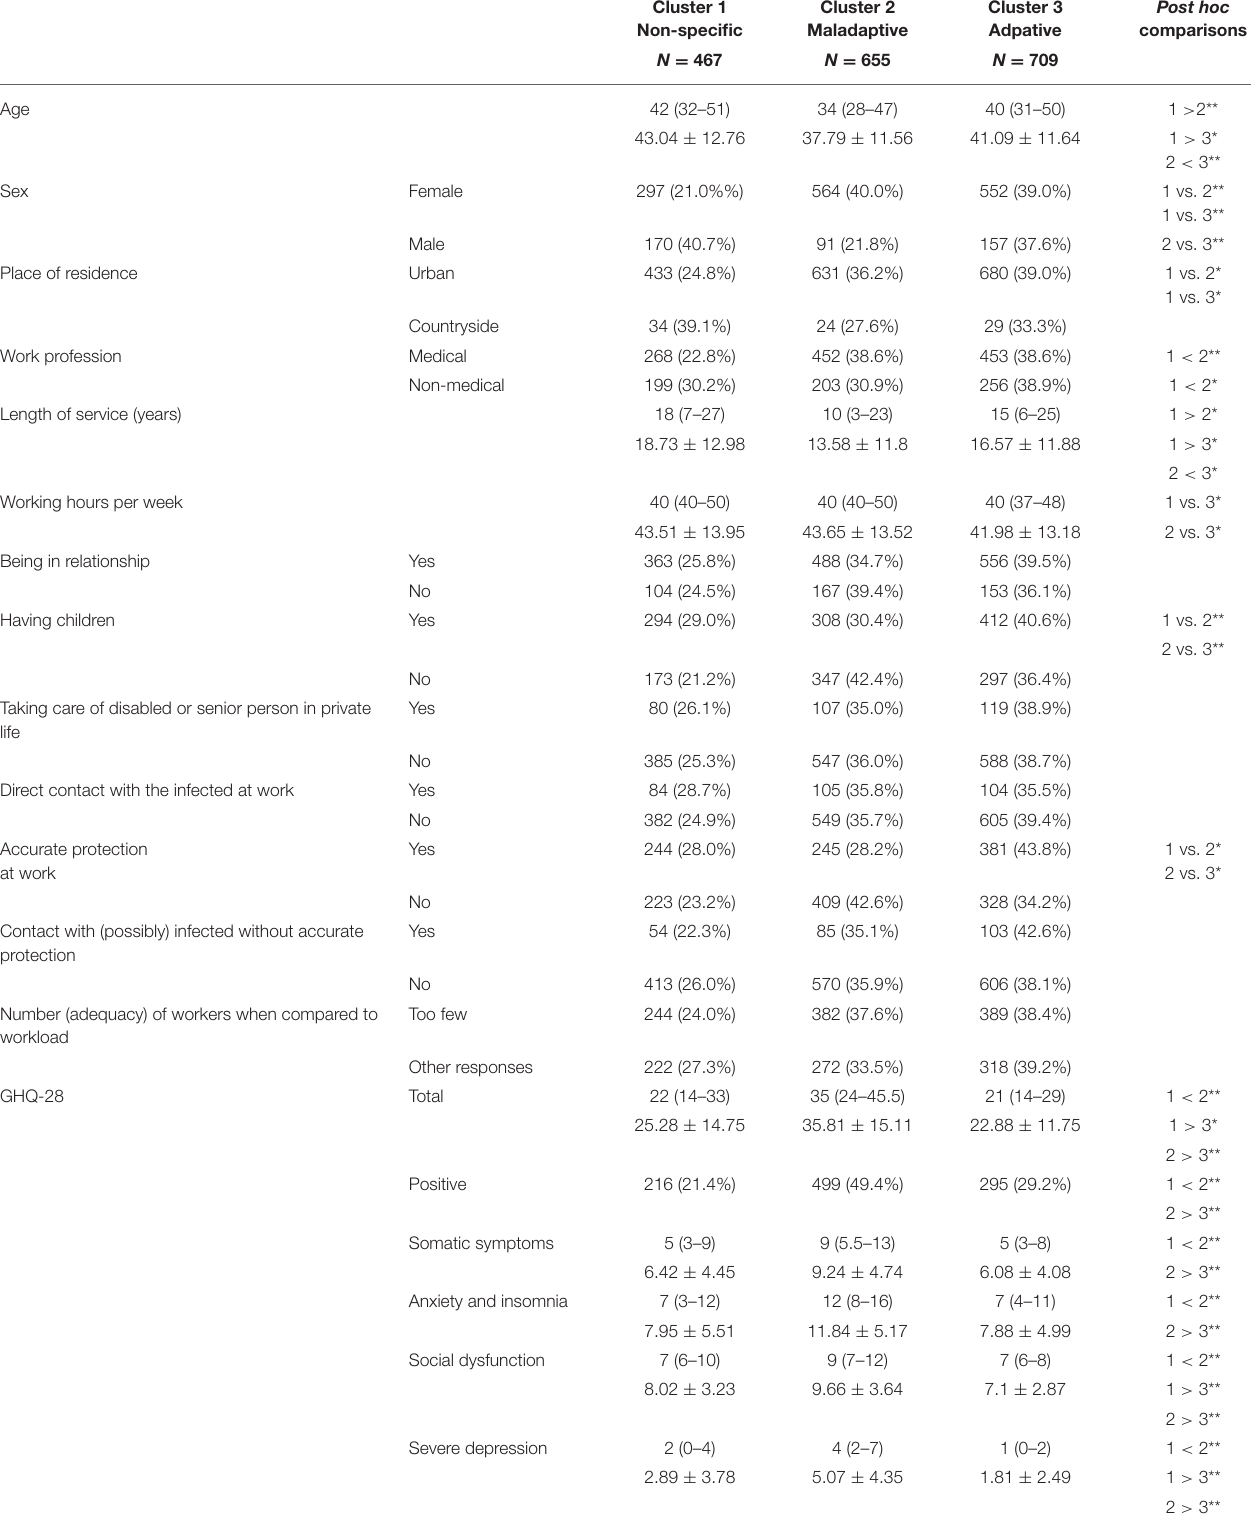
TABLE 2 | Descriptive analysis of the clusters regarding all